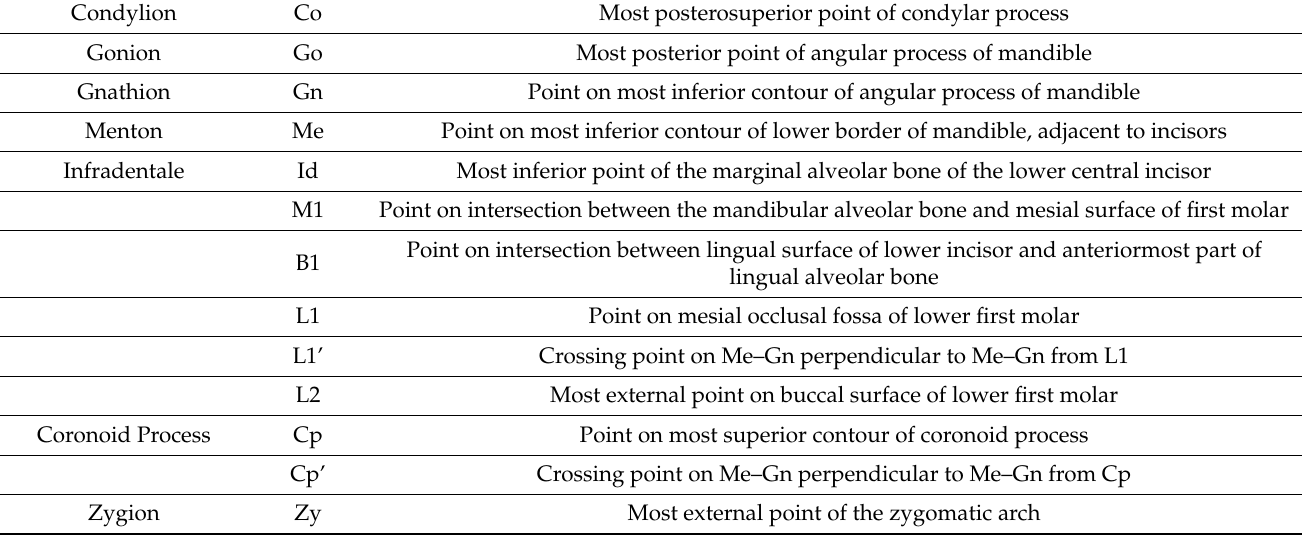
Table 2. The landmarks in mCT. The anatomic location of each landmark was shown in Figure 5. Condylion Co Most posterosuperior point of condylar process Gonion Go Most posterior point of angular process of mandible